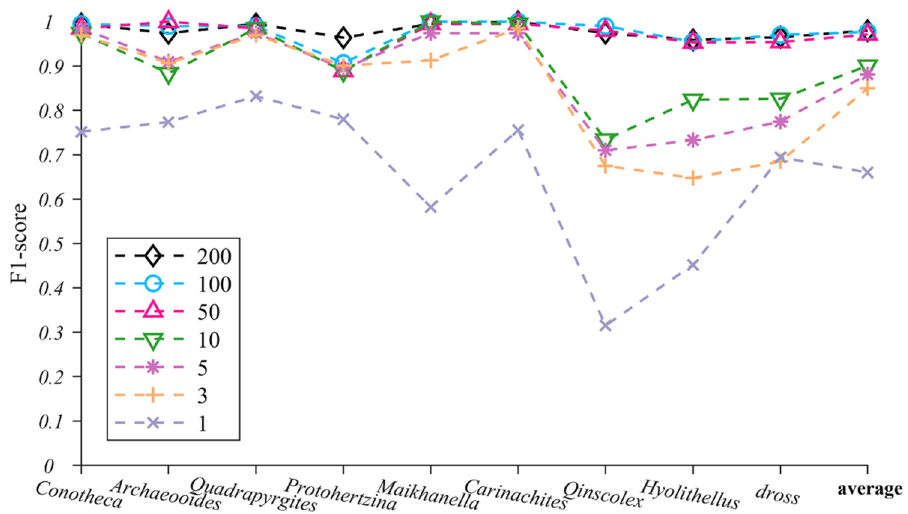
Figure 6. TS-ResNet’s F1-score changes for nine microfossils under different numbers of training images (the last item on the horizontal coordinate represents the average F1-score of nine microfossils).